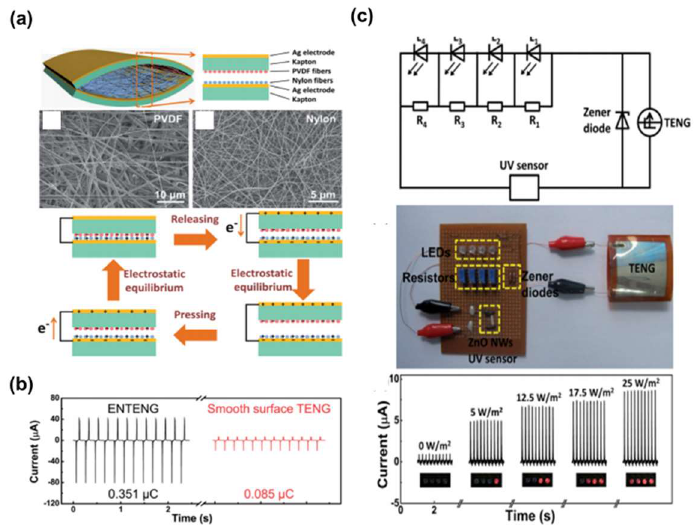
Figure 4. ( a ) The schematic of the TENG based on electrospun nanowires (ENTENG). SEM images of the electrospun PVDF and nylon nanofibers. The charge distribution in the device and the flowing direction in the circuit when the device is pressed and released. ( b ) The output current of the ENTENG and the output current of the smooth surface TENG with a similar device structure. ( c ) The schematic and optical images of the ultraviolet radiation (UVR) level detection system powered by an ENTENG. Current flowing across the UV sensor and the optical images of the LEDs at UV intensities of 0, 5, 12.5, 17.5, and 25 Wm − 2 . Reproduced with permission from Jing et al., Nanoscale 2014 , 6 , 7842–7846. Copyright 2014 The Royal Society of Chemistry.